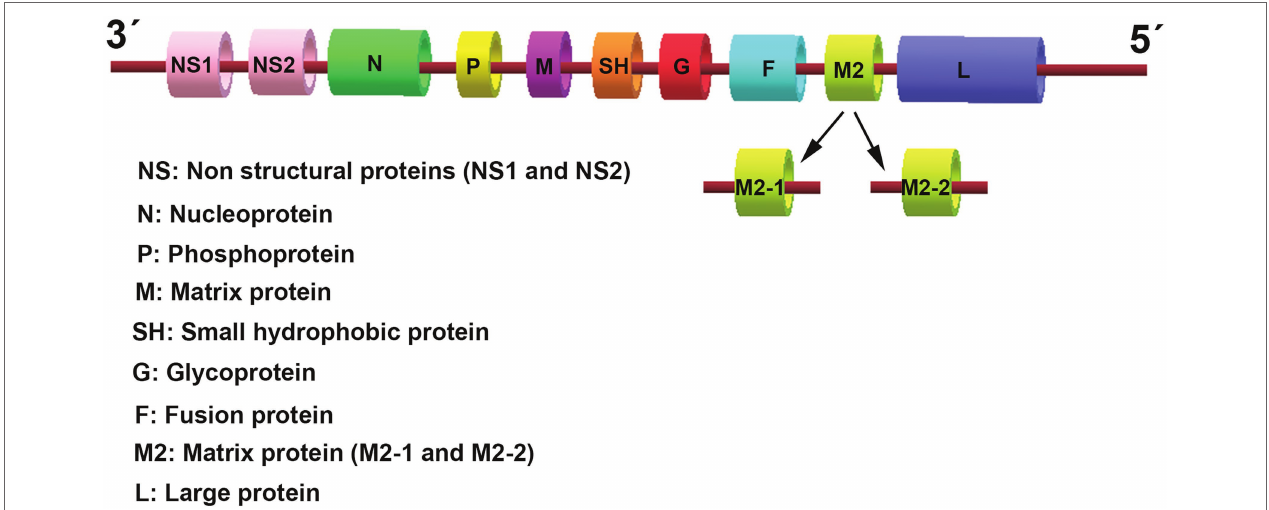
FIGURE 1 | The genomic organization of respiratory syncytial virus (RSV). The RSV genome is approximately 15.2 kb in size and encodes 10 genes that transcribe 11 proteins. The genome sequence from 3 ′ to 5 ′ successively encodes the non-structural (NS) proteins 1 and 2 (NS1/2), the nucleocapsid (N), the phosphoprotein (P), the matrix (M) protein, the small hydrophobic (SH) protein, the attachment (G) protein, the fusion (F) glycoproteins, the M2 gene-encoded two distinct matrix proteins M2-1 and M2-2, and the large polymerase (L)